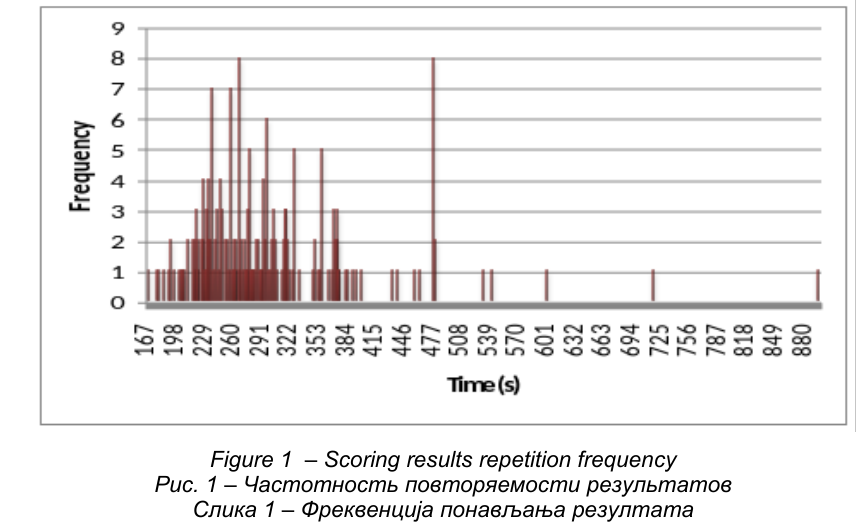
Figure 1 – Scoring results repetition frequency Рис . 1 – Частотность повторяемости результатов Слика 1 – Фреквенција понављања резултата